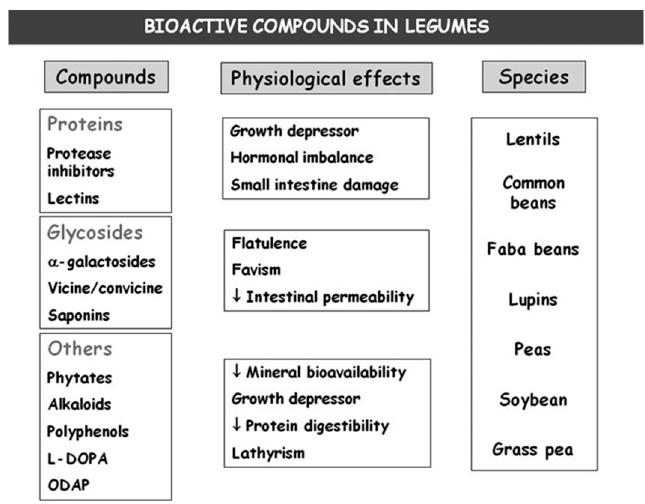
Figure 1. Bioactive compounds in legume seeds and their and physiological effects (adapted from Muzquiz et al., 2012 [4]). L-DOPA (L-Dopaminie), ODAP (oxalyl-L- α , β -diaminopropionic acid).